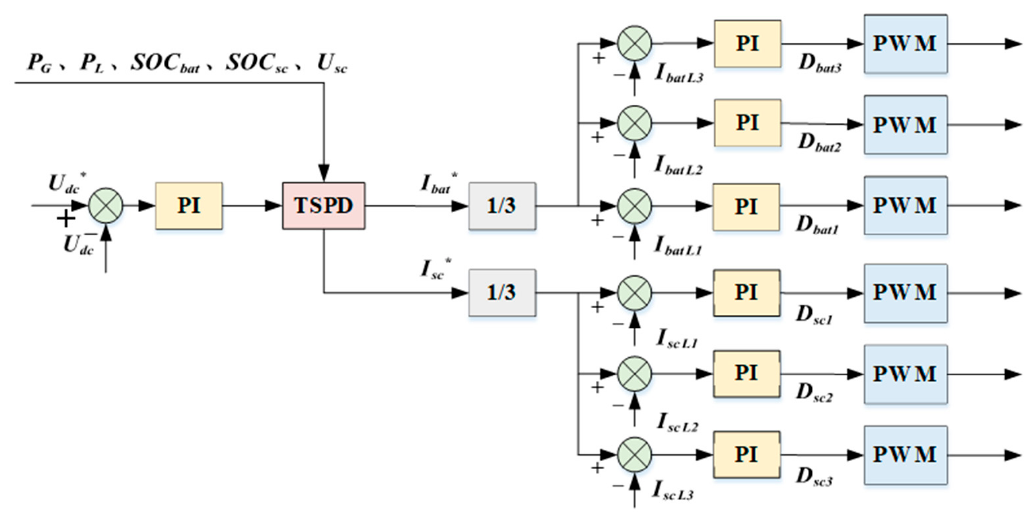
Figure 9. EMS process.